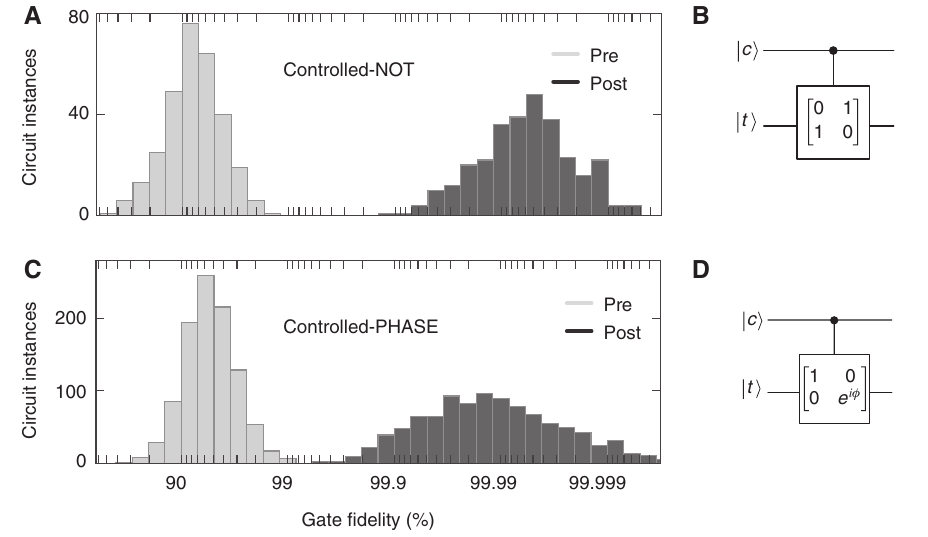
Figure 4: Improving postselected CNOT and CPHASE gate fidelities with a nonlinear optimization algorithm. (A) Performance of the CNOT gate program in a realistic simulation of the QPP architecture. Light and dark grey histograms plot fidelity before and after optimization of phase settings. (B) The CNOT gate flips the state of a target qubit | t 〉 if and only if a control qubit | c 〉 is present. (C) Preoptimization and postoptimization results for the CPHASE gate program within simulated QPPs. In each simulation, reported fidelities are the minimum over six different choices of the phase applied by the controlled operation, equally distributed from 0 to 2 π . (D) The CPHASE gate applies a phase shift to a target qubit | t 〉 if and only if a control qubit | c 〉 is present.